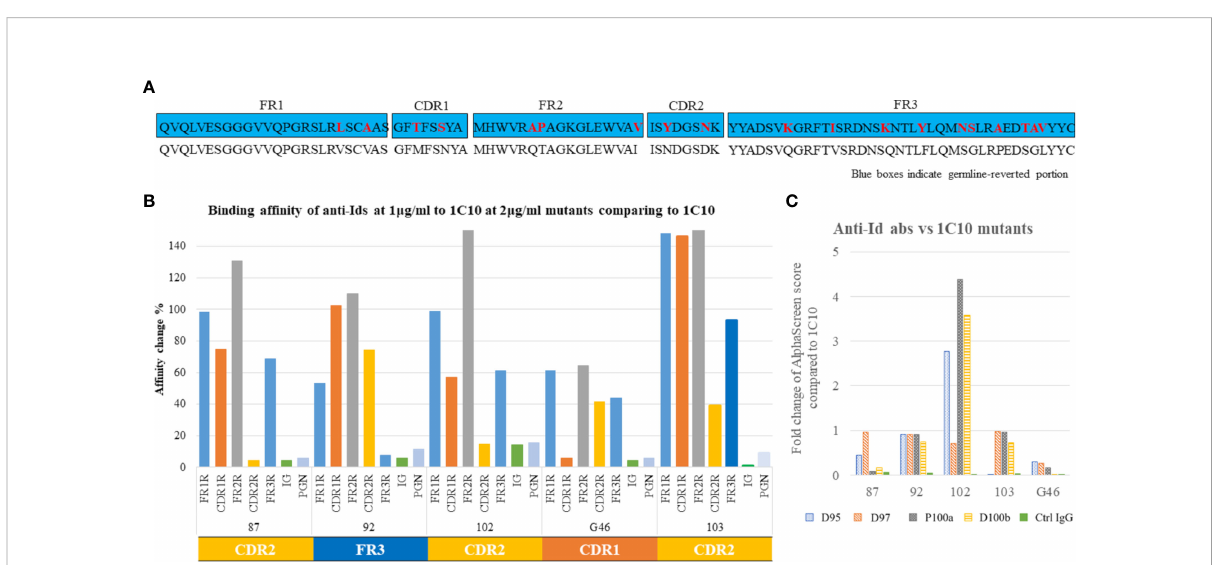
FIGURE 2 Idiotope classi fi cation. Germline reversion of 1C10 was created by overlap PCR to replace fi ve portions of the heavy chain variable region (VH), including framework regions (FR)1-3 and complementarity determining regions (CDR)1-2, with their germline amino acid (AA) sequences. Germline sequences are shown in blue boxes, with replaced AAs as red letters, and the 1C10 sequence is shown below the blue box. (A) Binding of anti-Id abs to germline-reverted 1C10, including inferred germline (IG) and human polyclonal IgG (Ctrl IgG), was tested by binding ELISA and expressed as percentage af fi nity change, calculated as a relative value based on binding to 1C10. The binding patterns of the anti-Id abs resulted in three types: CDR1-, CDR2-, and FR3-speci fi c types. (B) Alanine scanning mutagenesis was applied to four contact residues of 1C10 CDRH3 (D95, D97, P100a, and D100b). Binding ELISA was used to examine the binding of the anti-Id abs to the 1C10 mutants containing alanine (C)